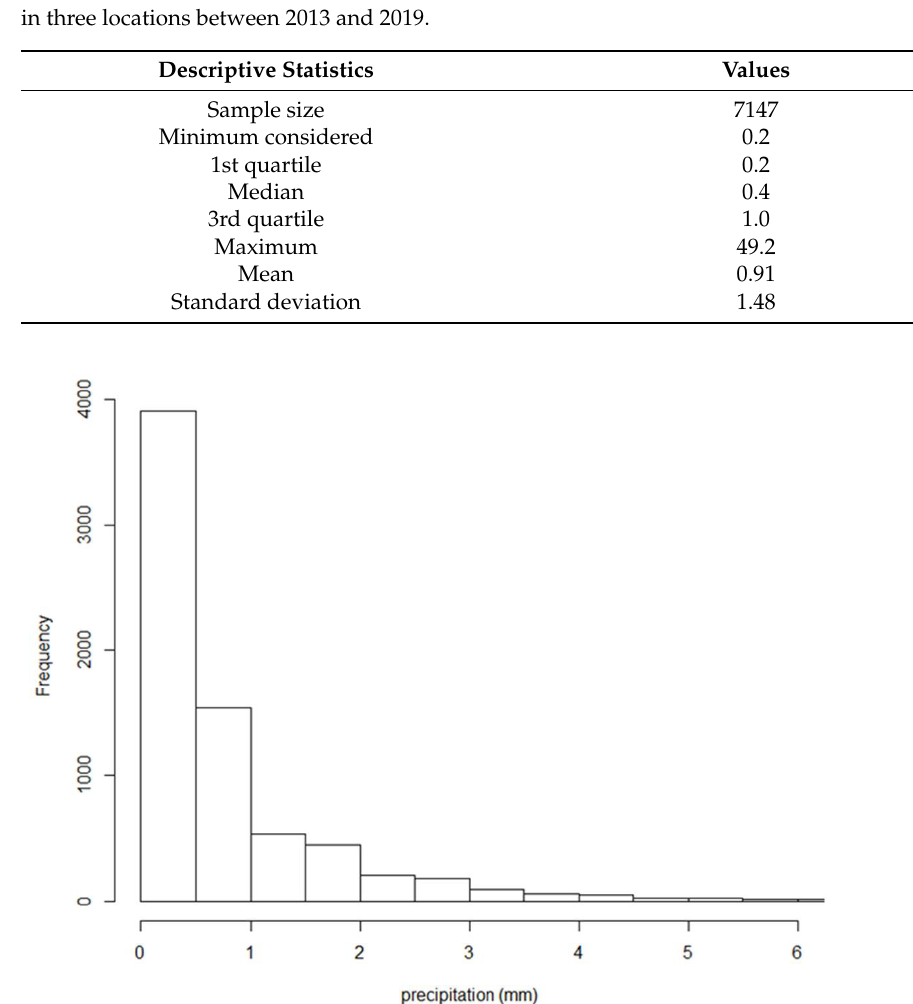
Figure 3. Histogram of precipitation indicating the number of hours of observations (frequency) of different amounts of precipitation (mm) in the three locations between 2013 and 2019.